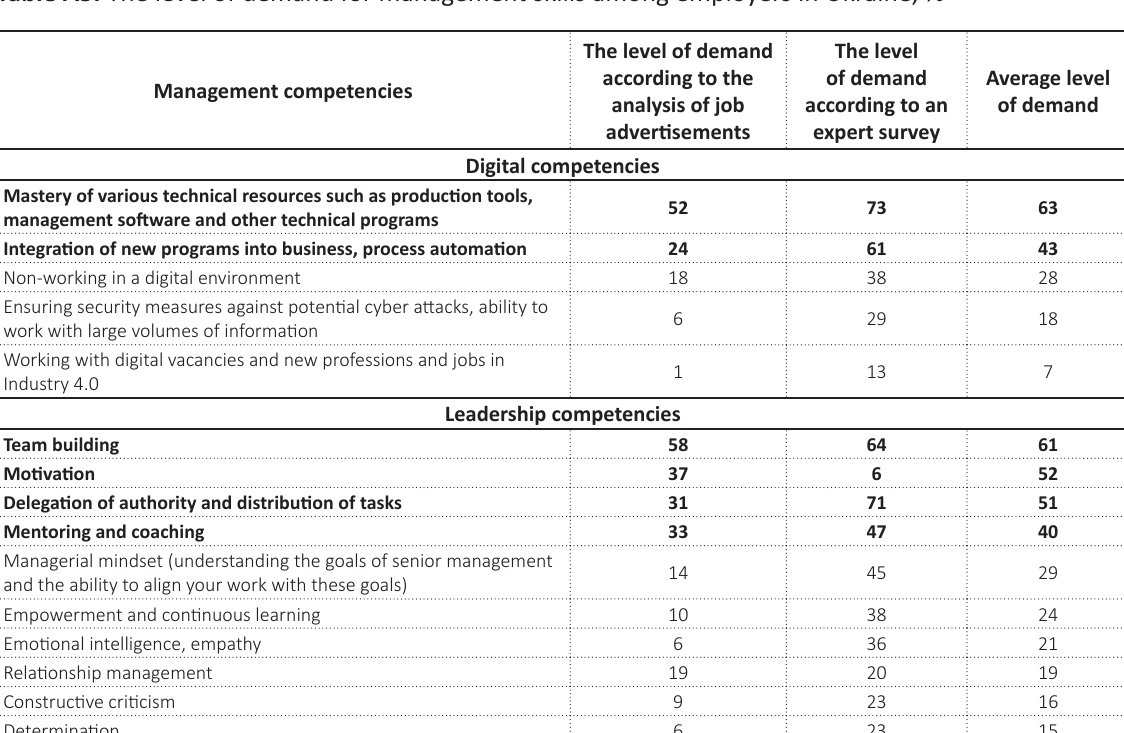
Table A5. The level of demand for management skills among employers in Ukraine, %